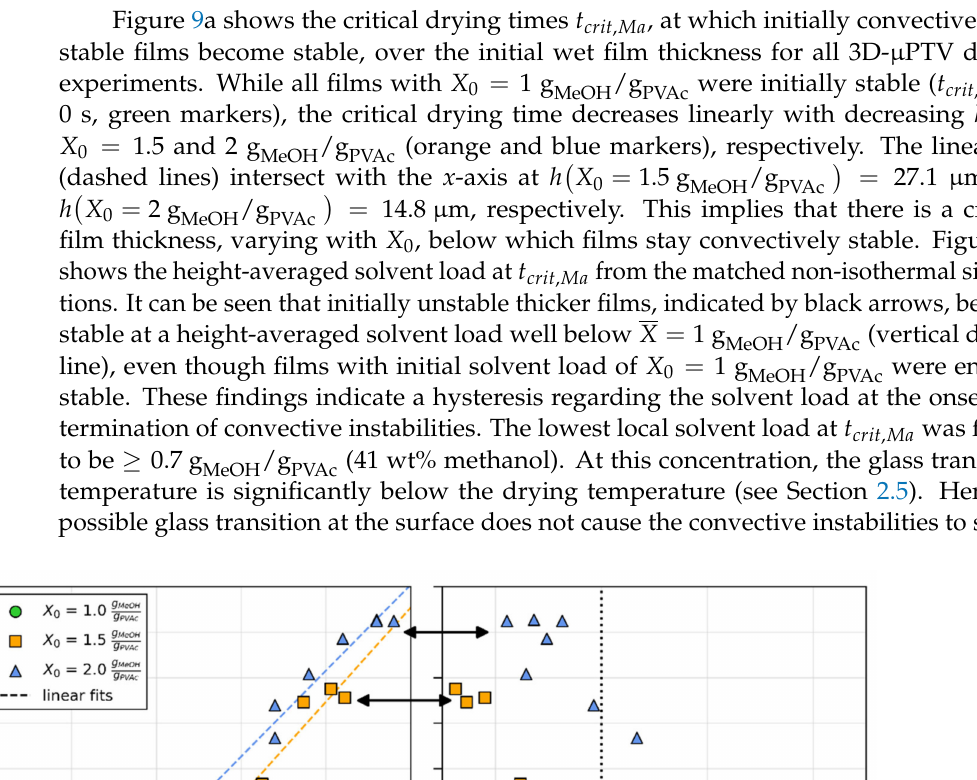
(cid:0) (cid:1) t crit , Ma from matched simulations. The black arrows denote /g , although experiments with initial solvent load X 0 = 1 g MeOH PVAc